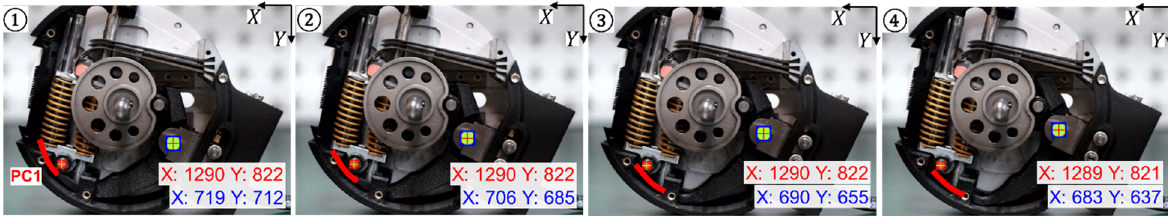
Figure 9. The visual measurement to verifying PC1 using marker tracking. The red and blue coordinates indicate the position of the spring follower and the pivot position with respect to the origin at the right top of the figure. The circled numbers show the order of pivot variation from the bottom pivot (circled number 1) to the top pivot (circled number 4). The total travel distance of the pivot is 10 mm. Through the proper design of PC1, the position of the spring follower does not be affected by the movement of the pivot.